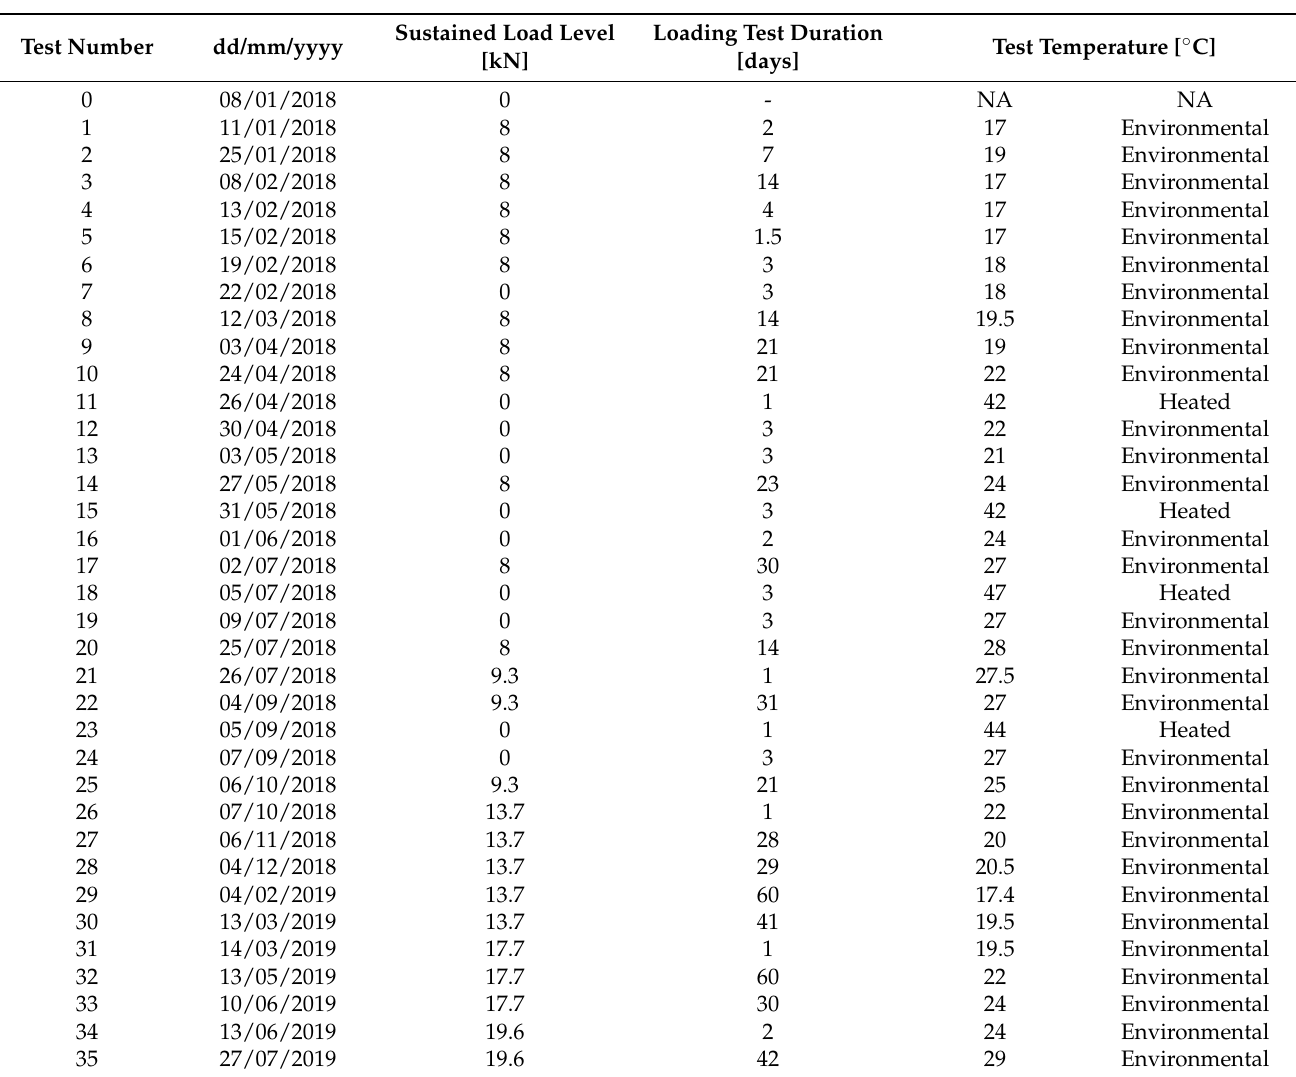
Table 2. Experimental